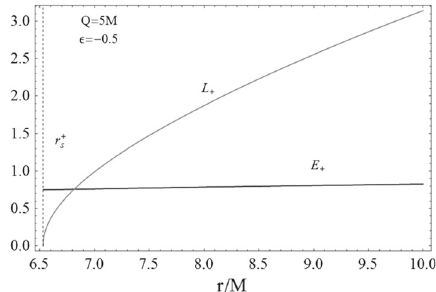
√ Fig. 27 Class : Q > 9 / 8 M and − 1 < (cid:2) < − M / Q . Parameter choice is as follows: Q = 5 M and (cid:2) = − 0 . 5. Then M / Q = 0 . 2, r + s = 6 . 5301 M . Circular orbits exist with angular momentum L = L + ( gray curve ) and energy E = E + ( black curve ) in r > r + s . For r = r + s , L = 0 √ Fig. 25 Class : M < Q ≤ 9 / 8 M and (cid:2) = − M / Q . Parameter choice is as follows: Q = 1 . 06 M . Then Q 2 /( 2 M ) = 0 . 5618 M , r − γ = 1 . 44708 M and r + γ = 1 . 55292 M . Circular orbits exist with angu- lar momentum L = L + ( gray curve ) and energy E = E + ( black curve ) in Q 2 /( 2 M ) < r < r − γ ( left plot ) and in r > r + γ ( right plot ). For r = Q 2 /( 2 M ) , L = 0